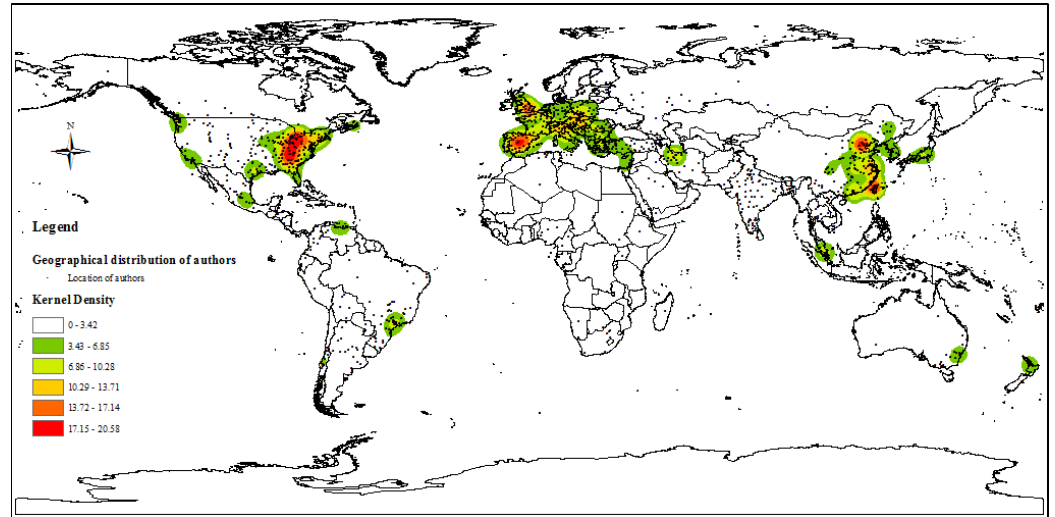
Figure 3. Kernel density estimation for the geographic distribution of authors